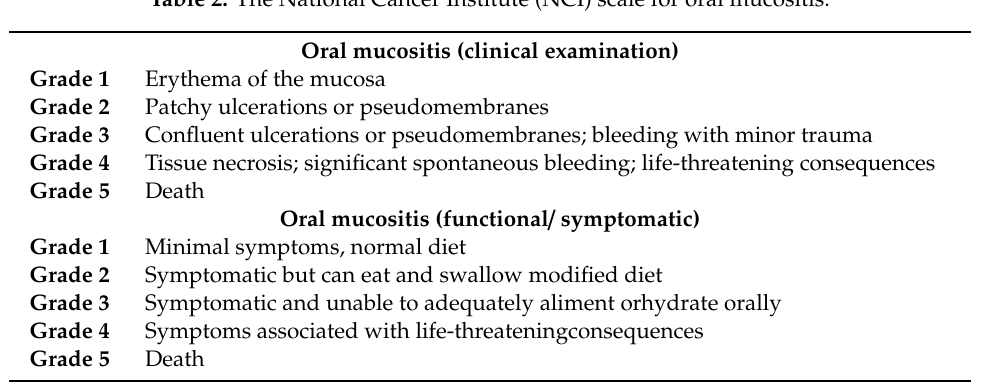
Table 2. The National Cancer Institute (NCI) scale for oral mucositis.